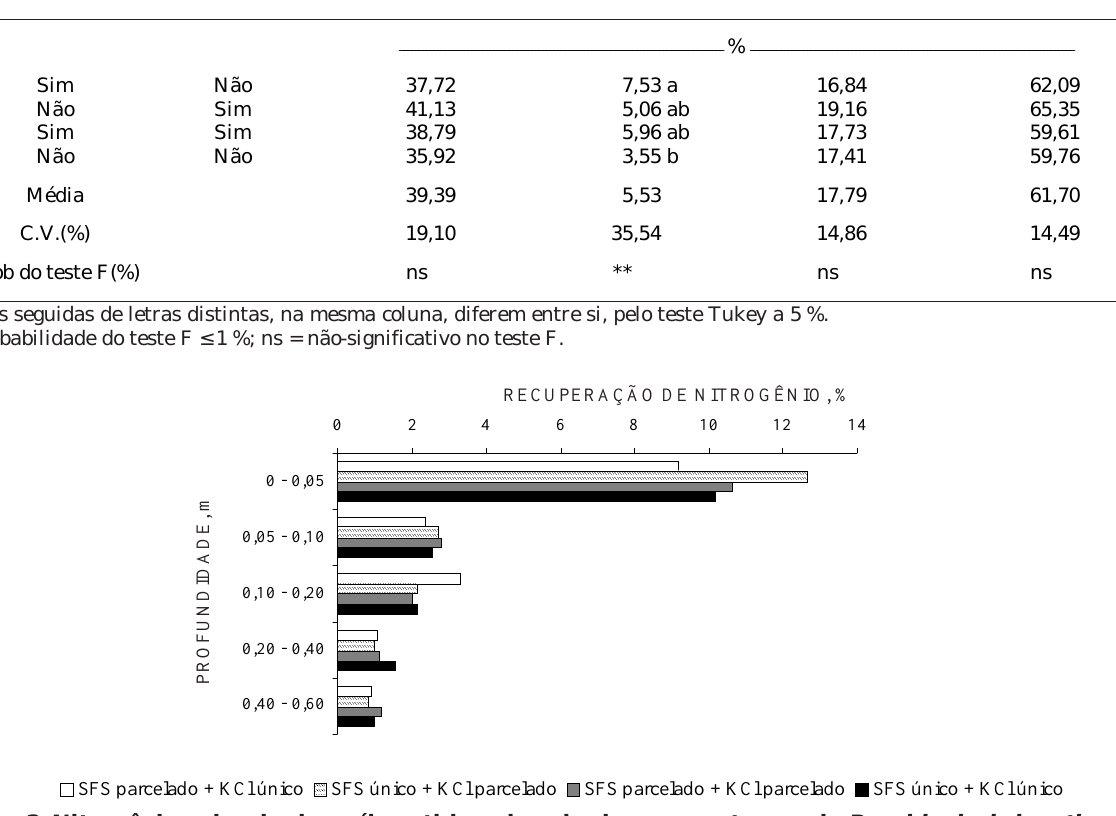
Figura 2. Nitrogênio oriundo da uréia retido pelo solo de uma pastagem de Brachiaria brizantha cv. Marandu em diversas profundidades no perfil.